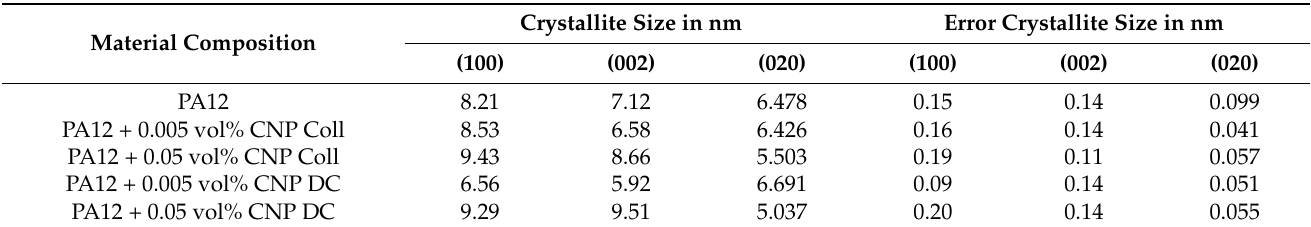
Table 3. Crystallite sizes in 100, 002, and 020 orientation for gamma PA12 in composite powder specimens as determined from Rietveld